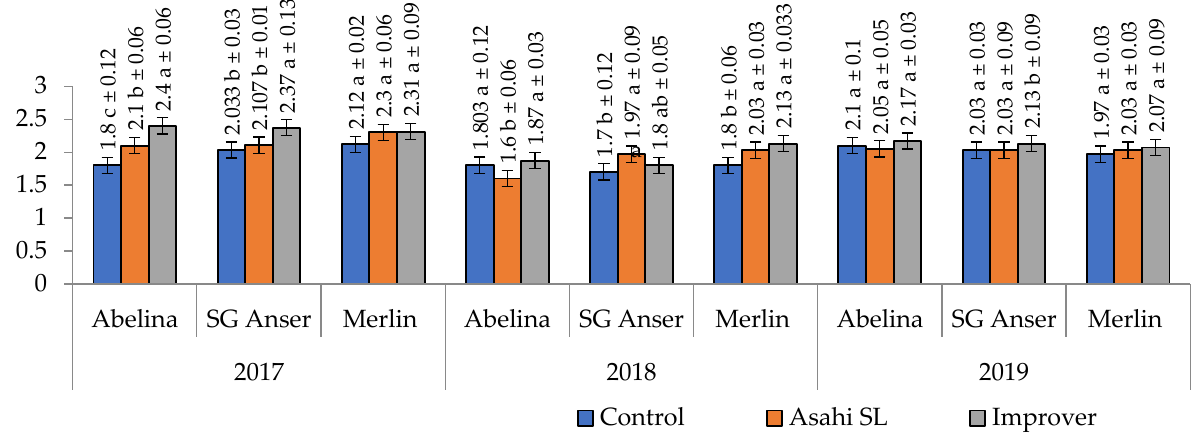
Figure 3. Seed number per pod according to biostimulants and cultivars in 2017–2019. Means followed by different letters in lowercase: a, b, and c differ significantly at p ≤ 0.05; ± Se (standard error) value. Table 5. Seed number per pod according to years, cultivars, and biostimulants.